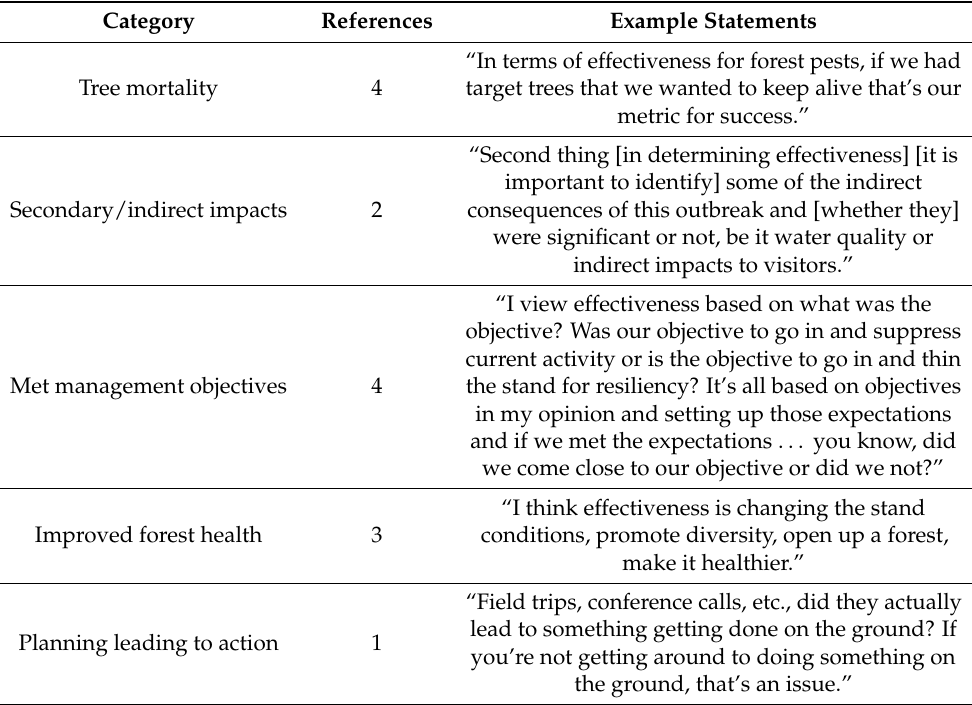
Table 1. Components of effective pest response as identified by interviewees, with example quotes illustrating each definition of effectiveness. “References” refers to the number of unique mentions of each